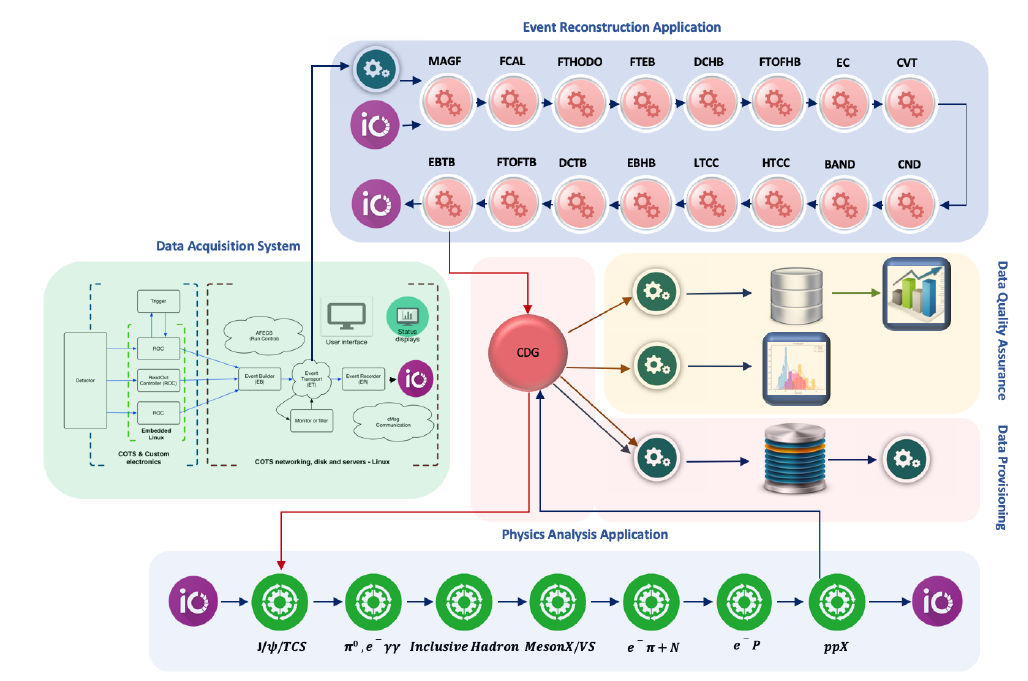
Fig. 3. CLAS12 data processing